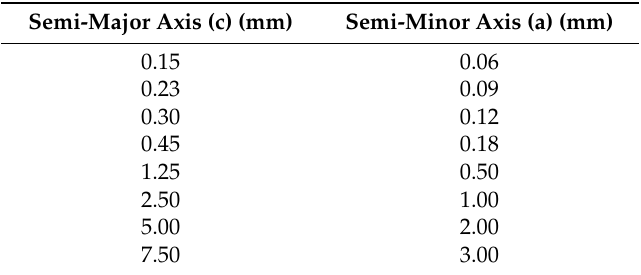
Table 6. Crack sizes of semi elliptical section using each iteration.